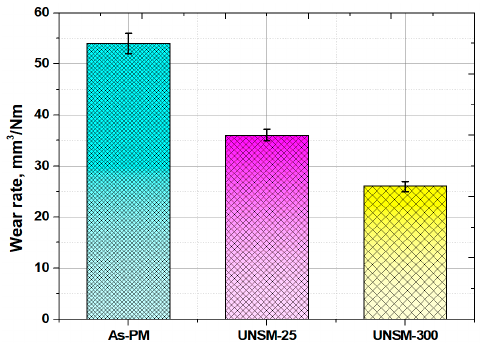
Figure 10. Wear resistance of the as-PM, UNSM-25 and UNSM-300 samples.